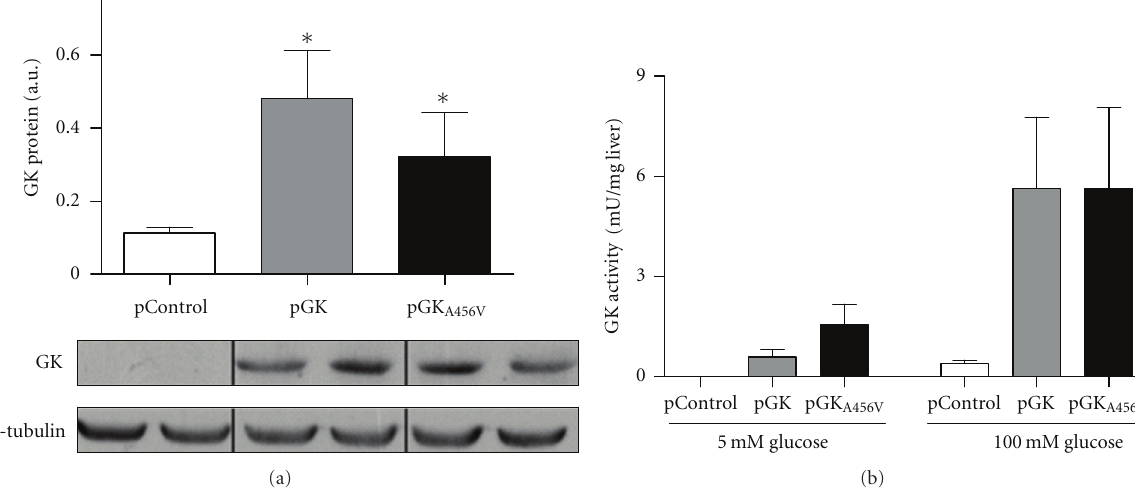
Figure 1: Rat GK and GK A456V overexpression in the livers of STZ-treated mice. 60 μ g of pControl, pGK, or pGKA 456V were hydrodynamically-transfected to diabetic mice. (a) GK protein content of liver homogenates was determined by Western blot. A representative blot and densitometric analysis is shown. (b) Further confirmation of GK overexpression was obtained by analysis of specific GK activity in liver extracts at di ff erent glucose concentration. Values are expressed as the means ± SE ( N = 4. ∗ P < 0 . 05 versus pControl).